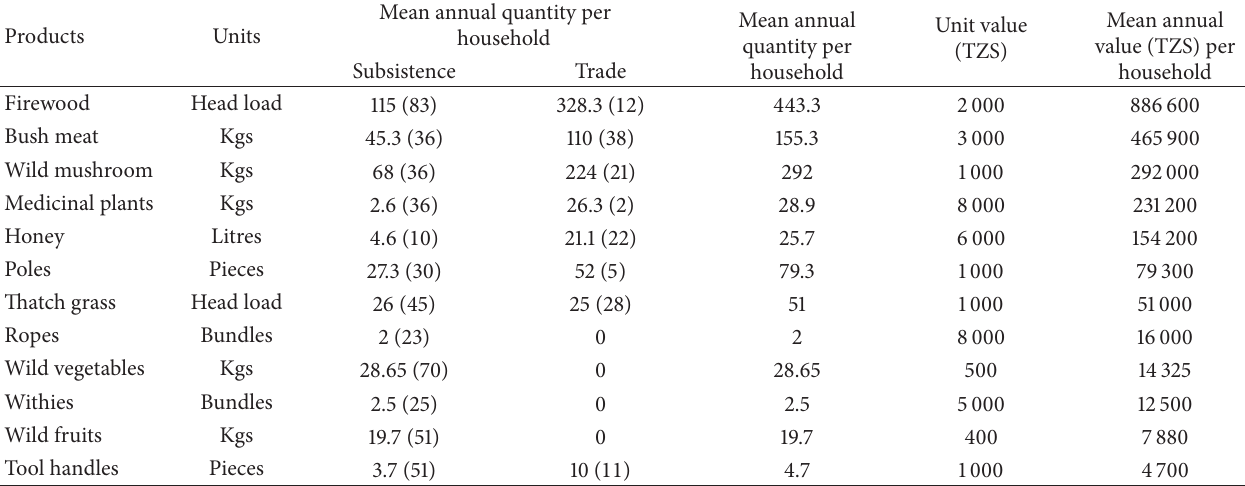
Table 4: Mean annual value of identified NTFPs in the study